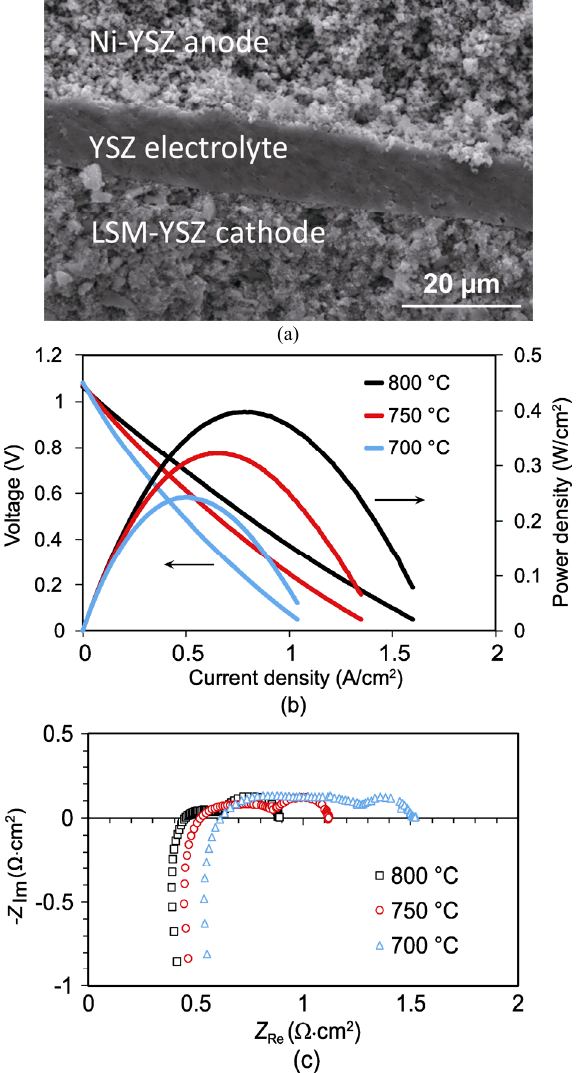
Fig. 10 Electrochemical testing of the single cell containing YSZ-HT electrolyte co-sintered at 1250 ℃ : (a) fractured cell cross-section; (b) I – V curves; (c) impedance